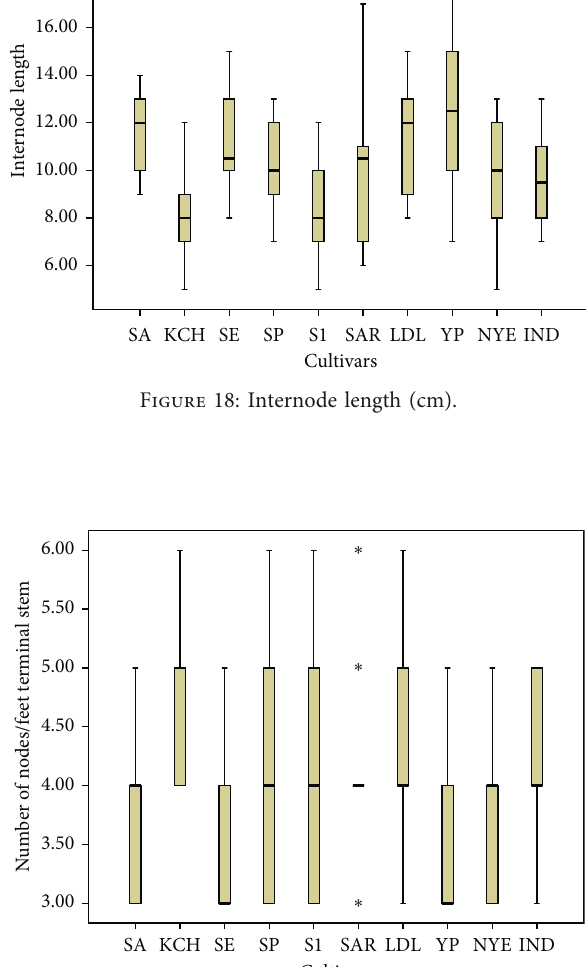
Figure 19: Number of nodes per foot of the stem.